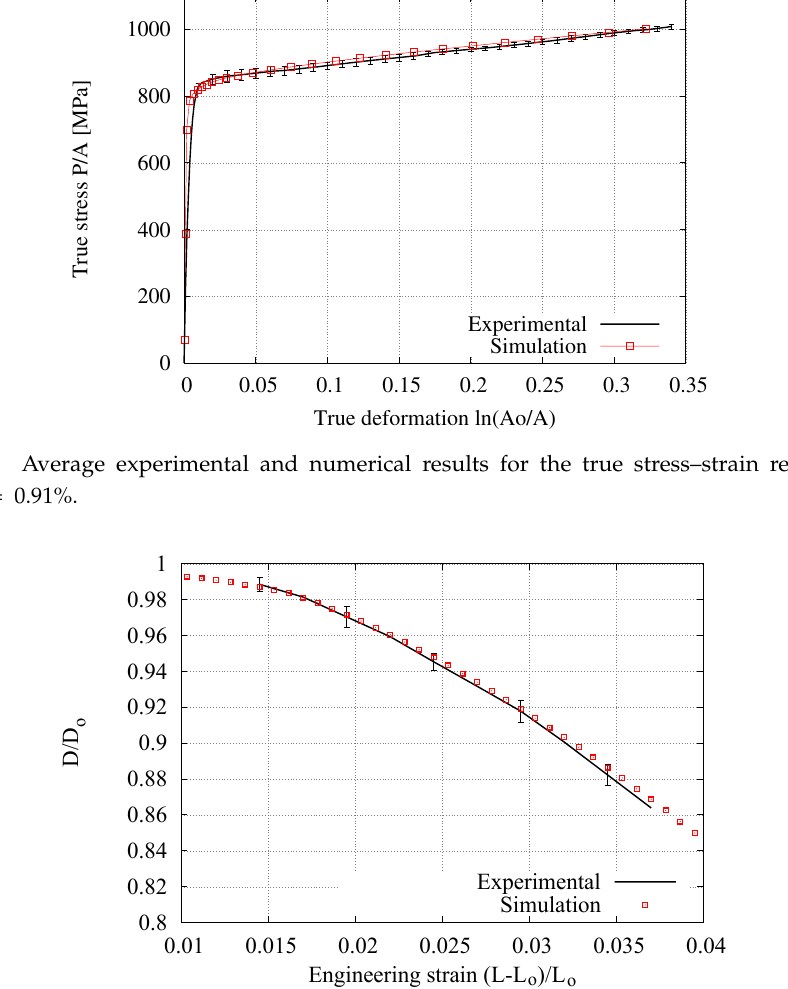
Figure 12. Average experimental and numerical results for the ratio of current to initial diameter at the necking zone versus axial elongation, NRMSD =